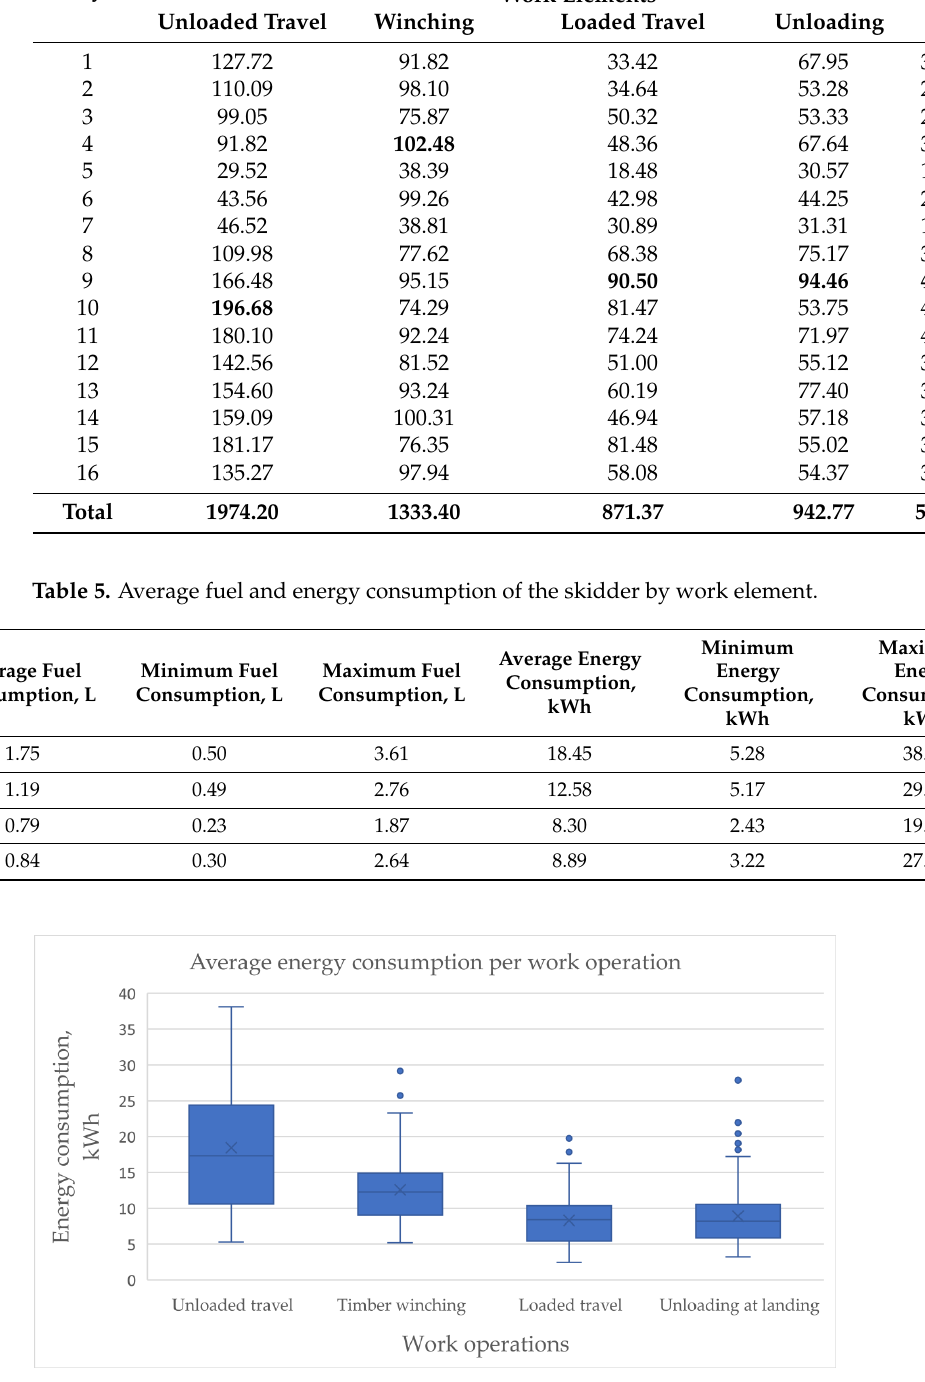
Figure 2. Average energy consumption of the skidder by work operations.